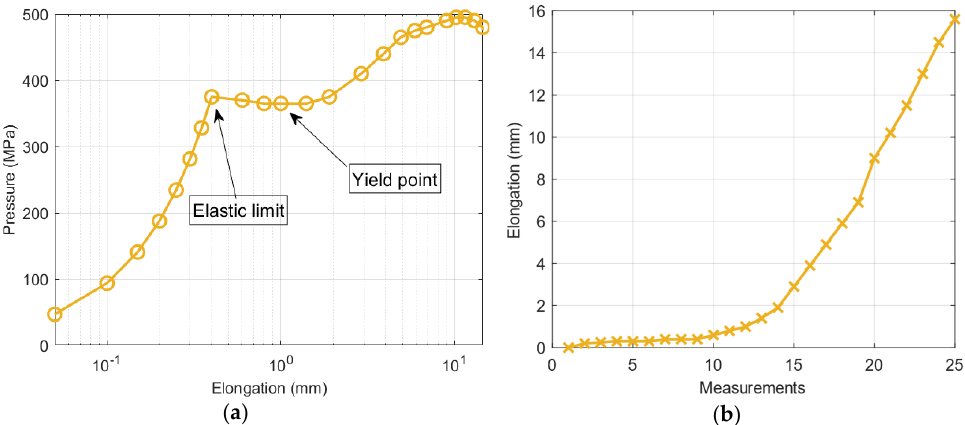
Figure 10. Strength characteristics for the tested specimen ( a ) and changes in the elongation for subsequent measurements ( b ).